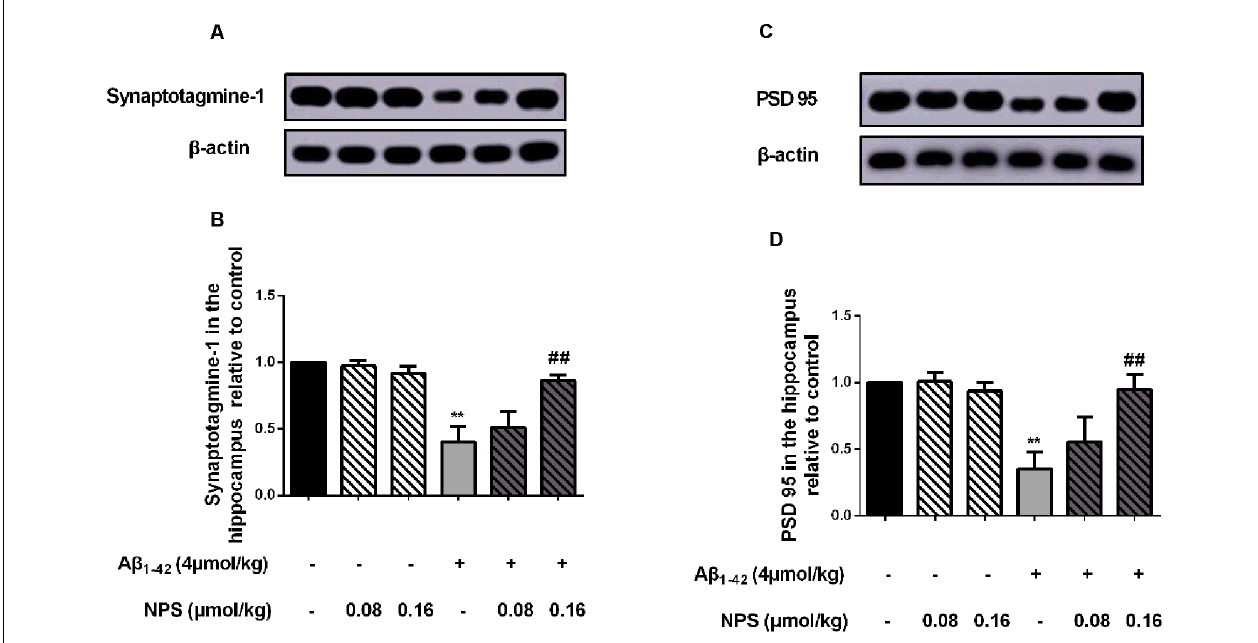
FIGURE 6 | Pharmacological inhibition of CaSR prevented the decreased expression levels of synaptotagmine-1 and PSD 95 induced by oligomeric A β 1–42 . (A) Sample western-blot plot of synaptotagmine-1 and β -actin in the control, the oligomeric A β 1–42 -treated group (4 µ mol/kg), and/or the NPS 2143-treated group (0.08 or 0.16 µ mol/kg). (B) Quantitative comparison of hippocampal synaptotagmin-1 level in different groups. (C) Sample western-blot plot of PSD 95 and β -actin in six groups. (D) Quantitative comparison of hippocampal PSD 95 level in different groups. ** P < 0.01 vs. control group, ## P < 0.01 vs. A β 1–42 oligomer-treated group. Values represent mean ± SEM, n = 6 animals for each